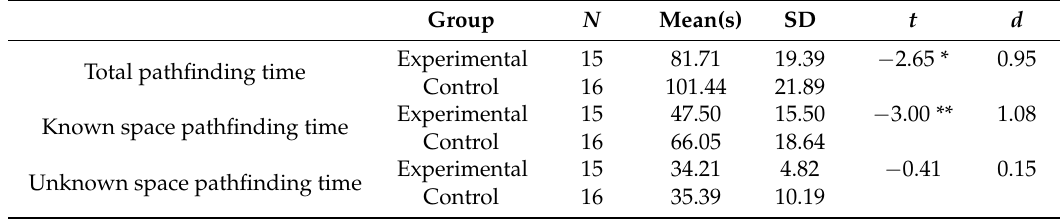
Table 3. Independent sample t -test of path-finding time between the two groups. Group Total pathfinding time